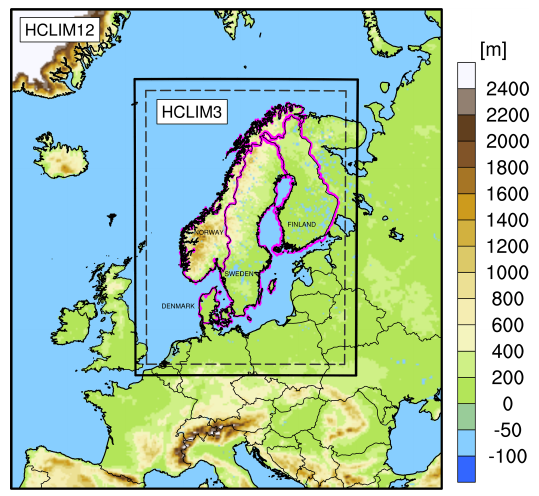
Figure 1. The model domains of HCLIM12 (outer rectangle) and nested HCLIM3 (inner rectangle). The color scale represents the altitude in meters. The country borders used in the analysis are marked with magenta. The analyzed sub-domain is marked with a dashed